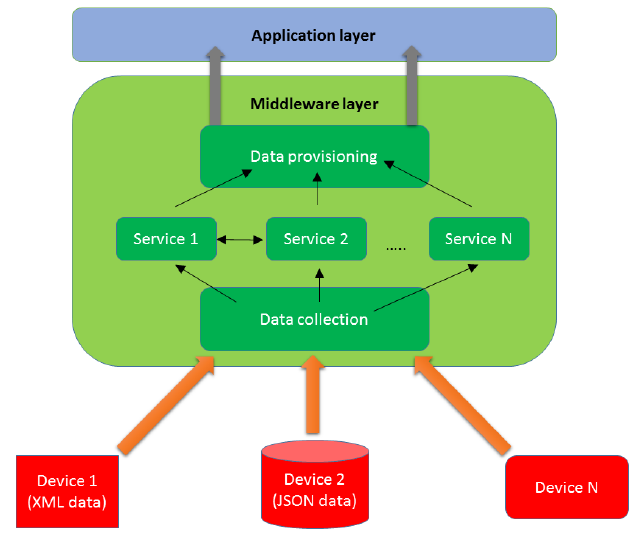
Figure 1. Middleware location in a distributed system.